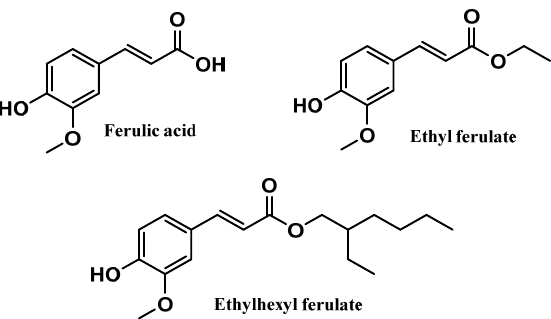
Figure 10. Chemical structure of ferulic acid and its derivatives.